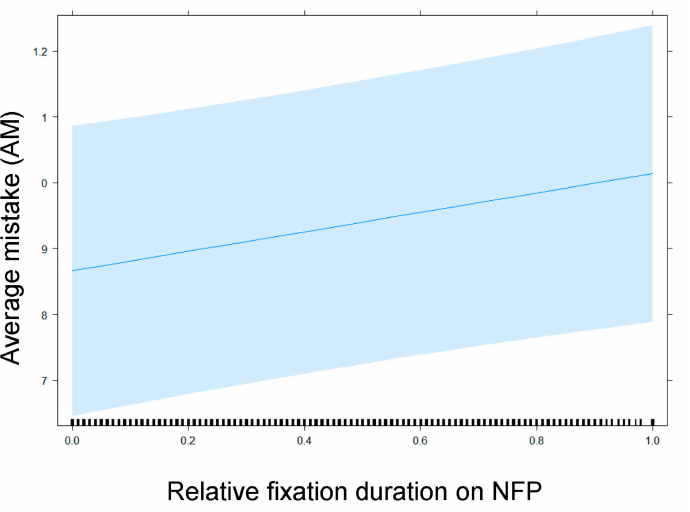
Figure 11. Impact of relative fixation duration on NFP on AM in the subset of participants exposed to products with